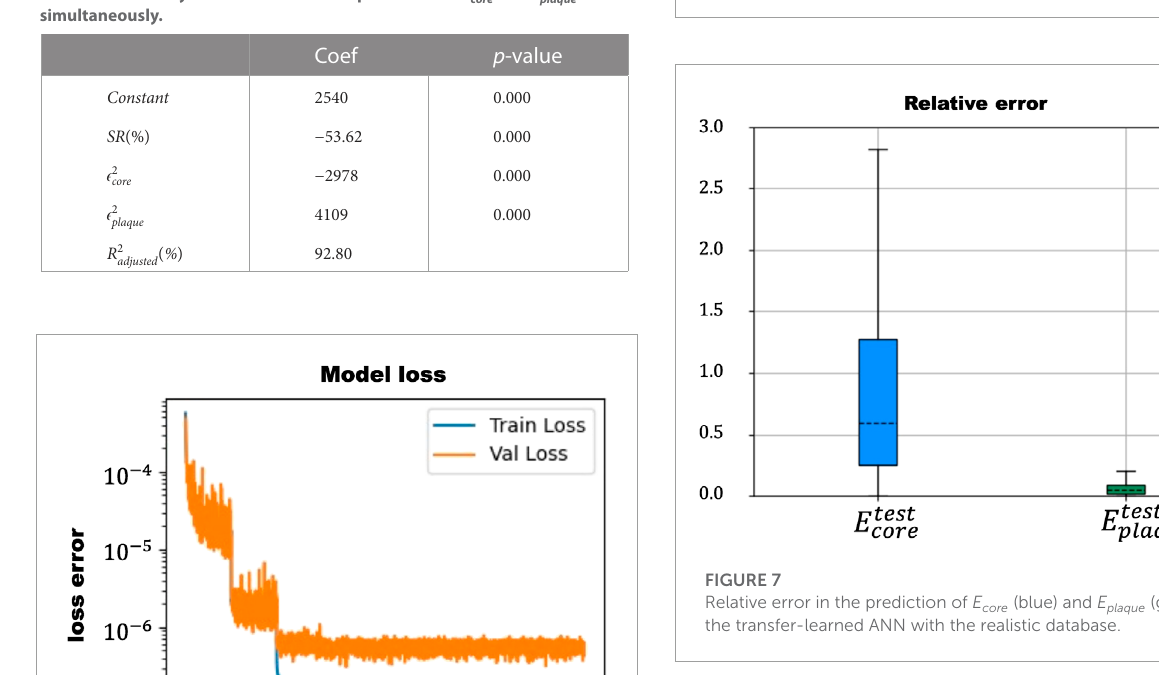
ToevaluatetheperformanceoftheANN,therelativeerrorinthe prediction of E and E was computed in three different core plaque